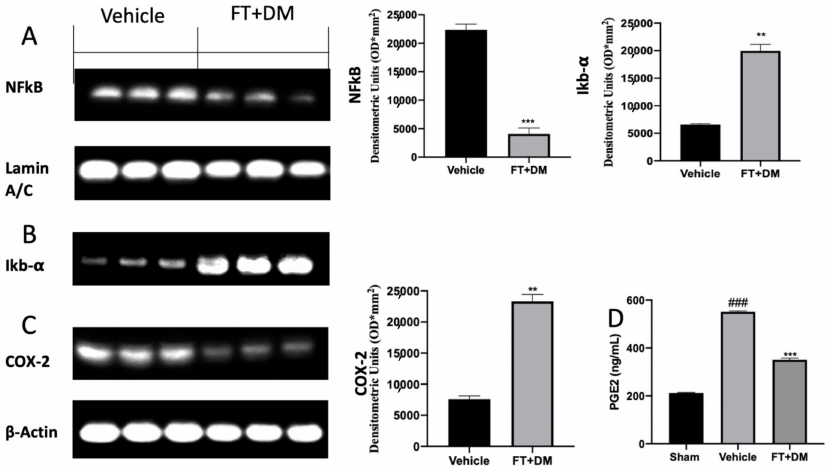
Figure 5. FT+DM administration reduced inflammation: Western blot analysis of NF κ B ( A ), I κ B- α ( B ) COX-2 ( C ) and PGE2 expression levels ( D ). A p -value of less than 0.05 was considered significant: ** p < 0.01 vs. vehicle, *** p < 0.001 vs. vehicle, ### p < 0.001 vs.